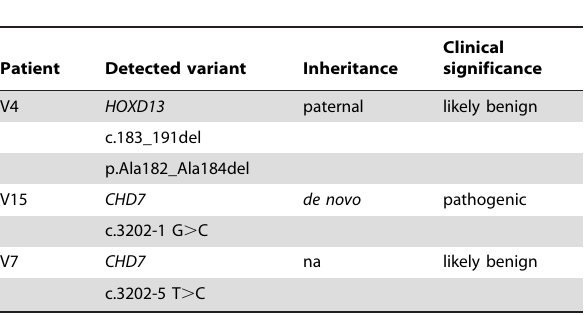
Table 4. Detected variants in HOXD13 and CHD7